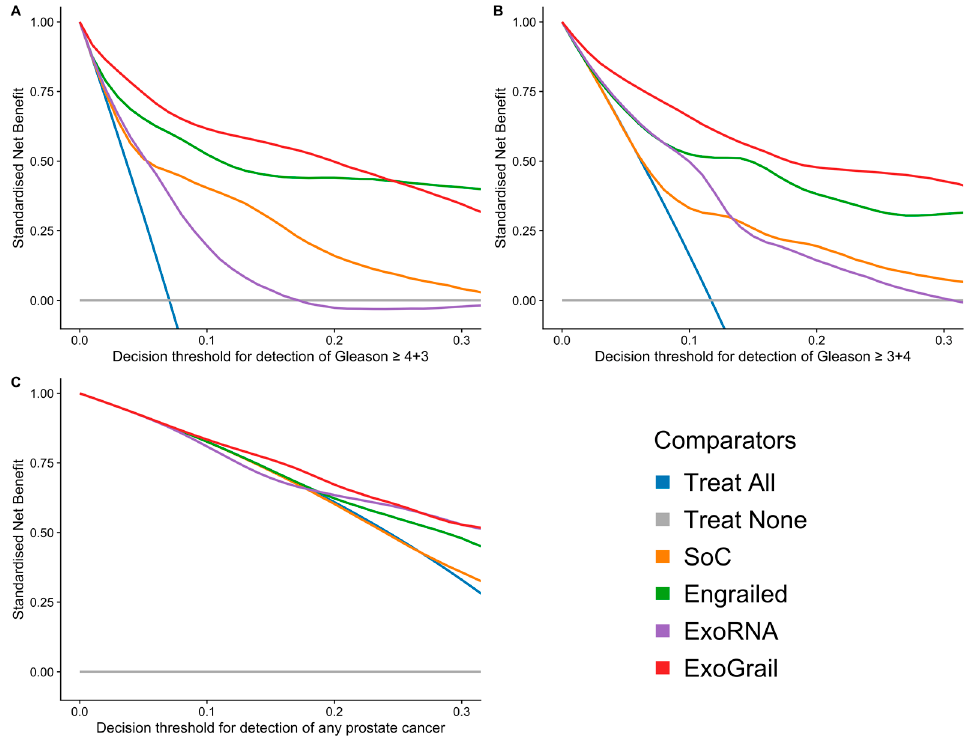
Figure 5. Exploration of the standardised net benefit (sNB) by decision curve analysis (DCA) for adopting risk models to aid the decision to undertake an initial biopsy for patients presenting with a serum PSA ≥ 4 ng/mL, where current clinical practice is to biopsy all patients. The accepted patient/clinician risk threshold for accepting biopsy is detailed on the x-axis. Different biopsy outcomes are shown in each of the three panels; ( A ) detection of Gleason ≥ 4 + 3, ( B ) detection of Gleason ≥ 3 + 4, ( C ) any cancer; Blue—biopsy all patients with a PSA >4 ng/mL, Orange—biopsy patients according to the SoC model, Green—biopsy patients based on the Engrailed model, Purple—biopsy patients based on the exoRNA model, Red—biopsy patients based on a the ExoGrail model. To assess the benefit of adopting these risk models in a clinically relevant population, we used data available from the control arm of the The Cluster Randomized Trial of PSA Testing for Prostate Cancer (CAP) study [42] for proportionally resampling the ExoGrail cohort. DCA curves were calculated from 1000 bootstrap resamples of the available data to match the distribution of disease reported in the CAP trial population. Mean sNB from these resampled DCA results are plotted here. See Methods for full details.